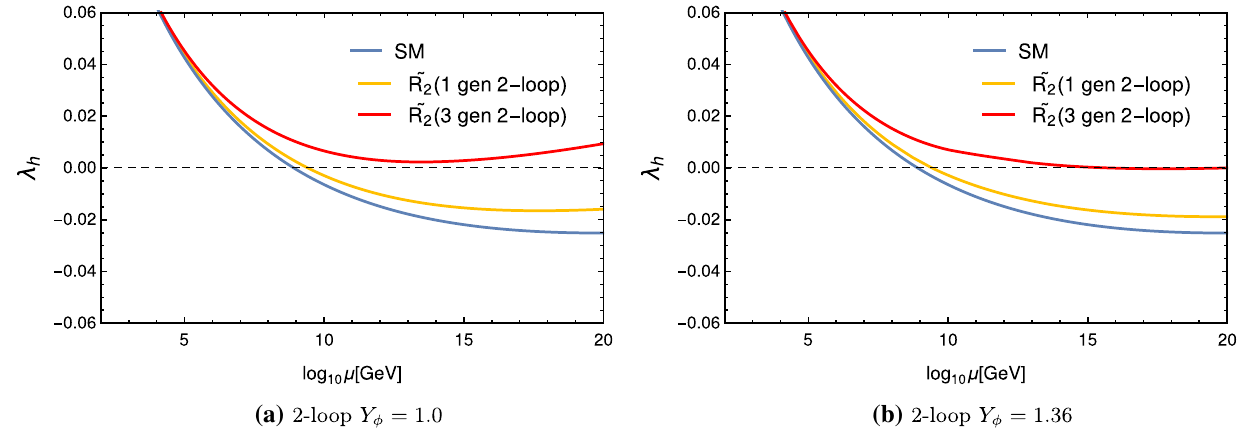
( a ) (b) Fig. 9 Running of SM Higgs quartic coupling with scale for stability plings is large enough and is compensated by the negative contribution of Y 2 . The crucial value of Y 2 is 1.36; λ h will go negative if higher analysis. Stability scale is defined as the scale after which λ h < 0. Here, blue, yellow and red curves describes the running of λ h for SM, one values of Y 2 are considered and stability is lost. On the other hand, for generation and three generations of (cid:2) R 2 . With three generations of (cid:2) R 2 , one generation of (cid:2) R 2 , λ h always goes to a negative value before Planck the positive contribution from gauge couplings and other quartic cou-